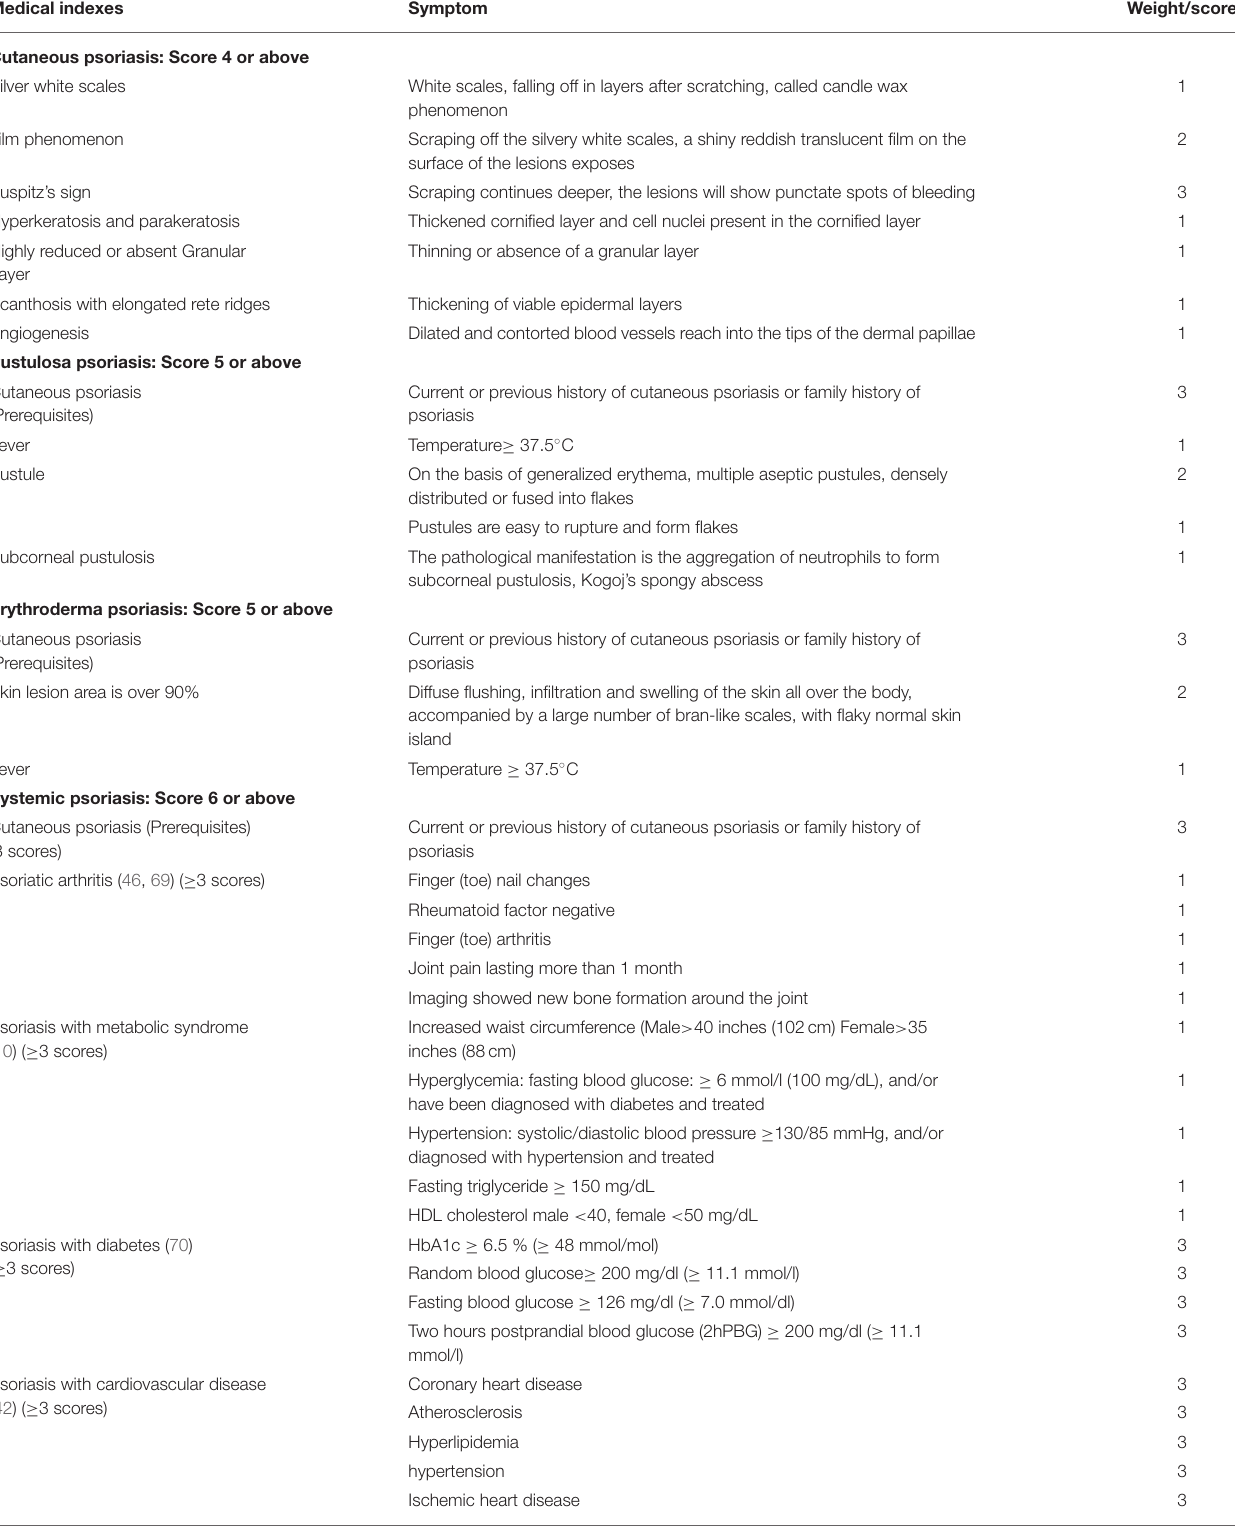
TABLE 2 | Classification criteria for psoriasis from CPRWERG. Medical